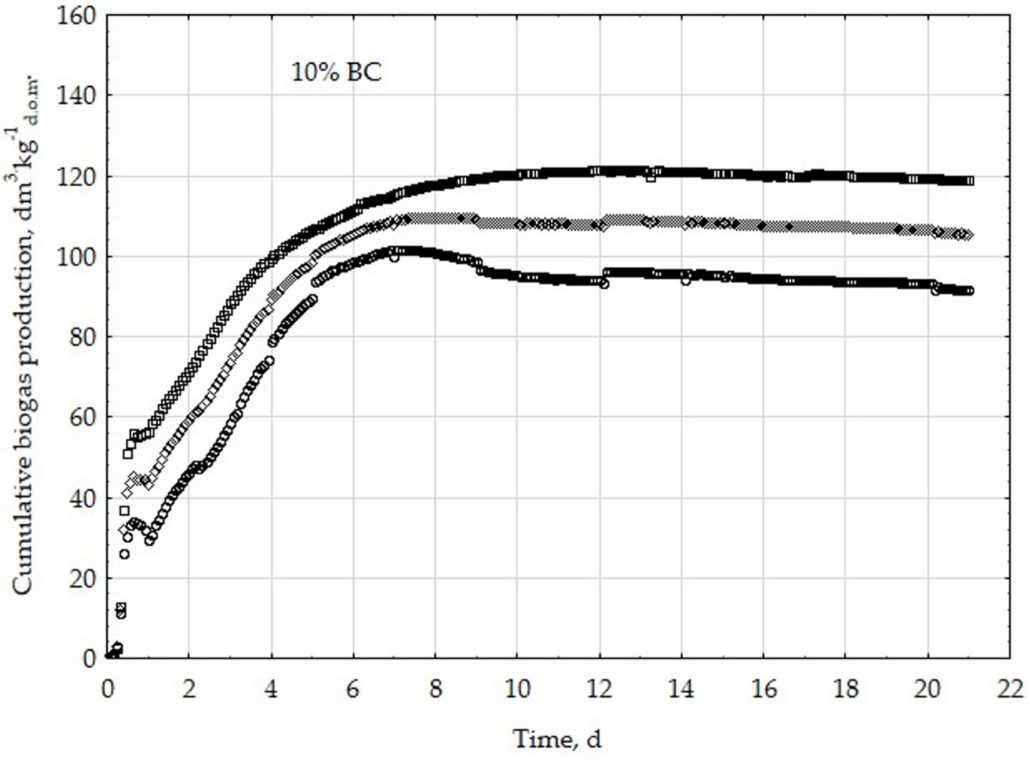
Figure A6. Biogas production from BSG: cumulative curves in variant with biochar addition at the level of 10%. The number of repetitions was